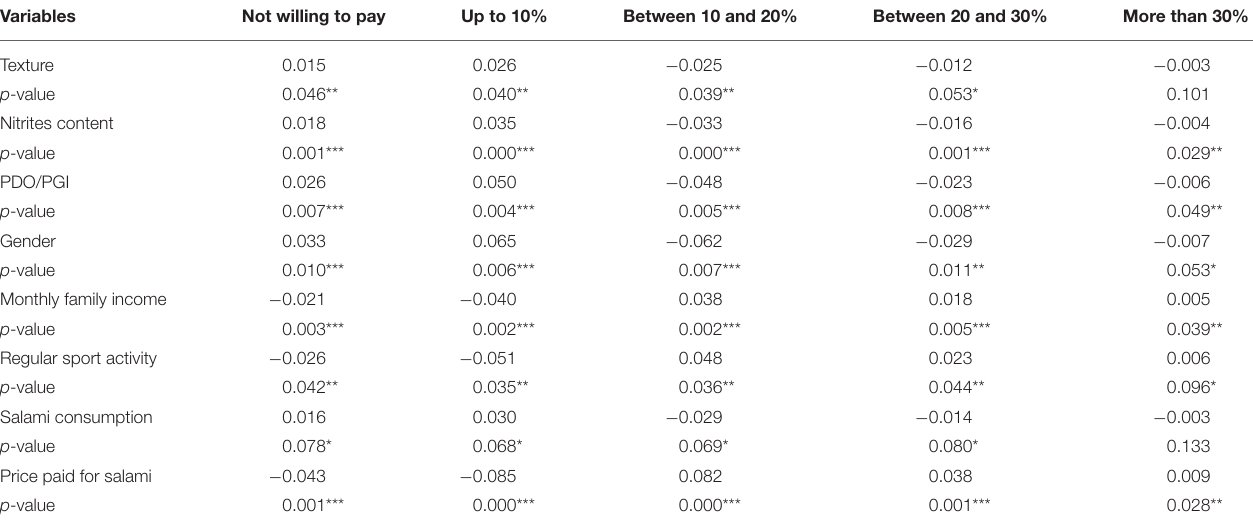
TABLE 5 | Average marginal effects for significant variables derived from the ordered logit model.